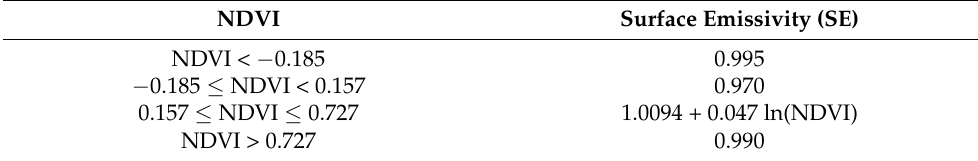
Table 1. Emissivity estimation using normalized difference vegetation index